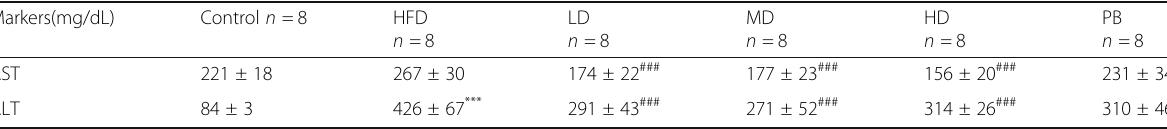
Table 1 Changes in serum markers representing liver